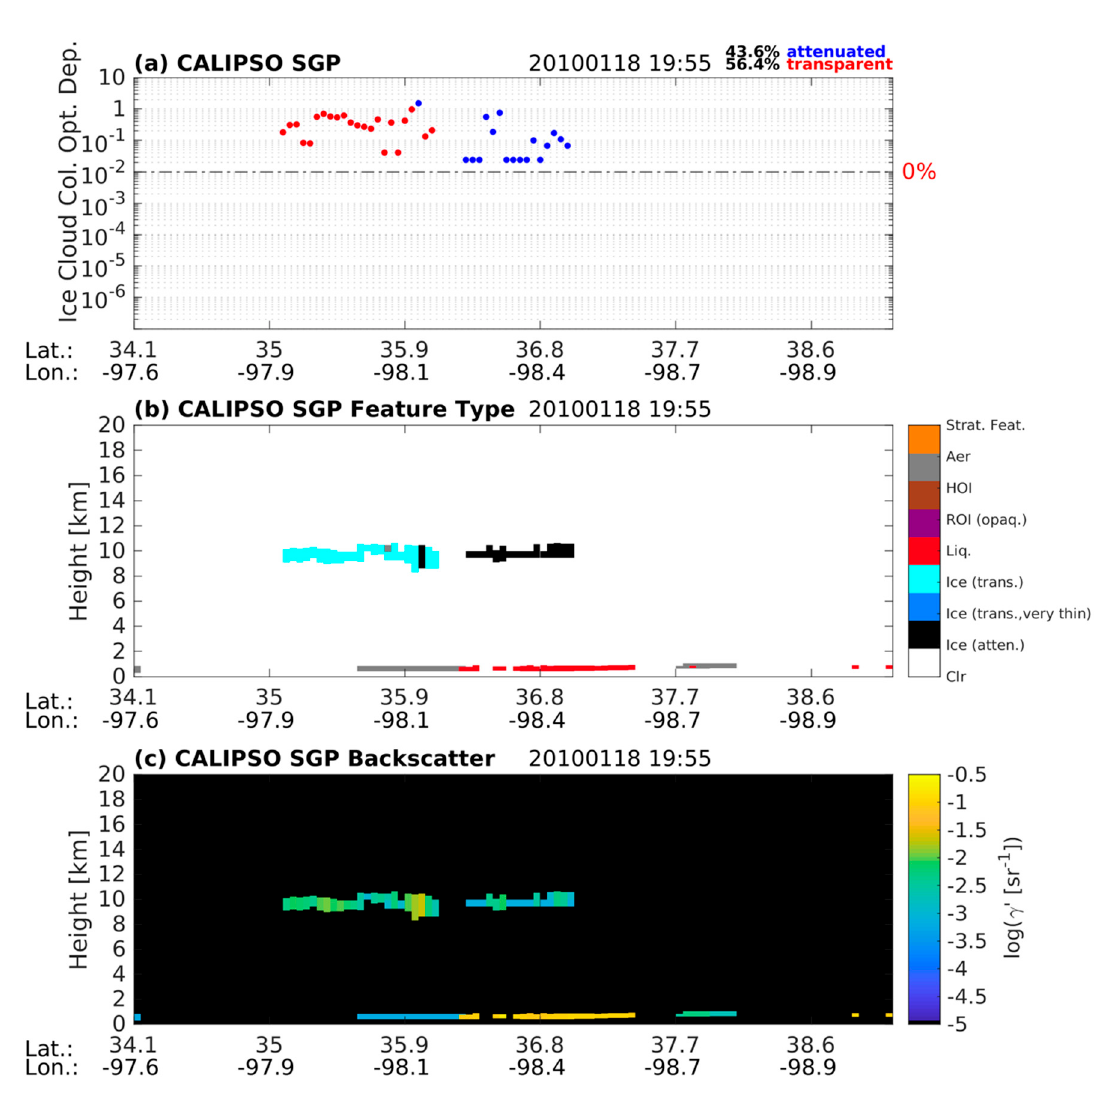
Figure 2. CALIPSO retrievals on 18 January 2010 over the SGP site for collocated profiles with RL (within 5 ◦ latitude by 5 ◦ longitude box centered over SGP). ( a ) Ice cloud column optical depths for transparent profiles (red) and attenuated profiles (blue) versus latitude/longitude. The optically very thin ice cloud threshold ( τ i , c < 0.01) is denoted by the dot-dashed black line. The percentage of transparent ice cloud column optical depths below this threshold compared to all transparent ice cloud column optical depths for this collocated section is labeled to the right of the graph. The percentage of ice cloudy profiles that are transparent and attenuated are given above the graph to the right. ( b ) Feature classification as either liquid cloud (red), opaque randomly-oriented ice clouds (purple), horizontally-oriented ice (HOI; brown), aerosol (gray), stratospheric feature (orange), transparent ice clouds with τ i , c ≥ 0.01 (light blue), transparent ice clouds with τ i , c < 0.01 (dark blue) or attenuated ice clouds (black). ( c ) Layer-integrated attenuated backscatter ( γ (cid:48) , expressed as the log, units: sr − 1 ) for all features detected.